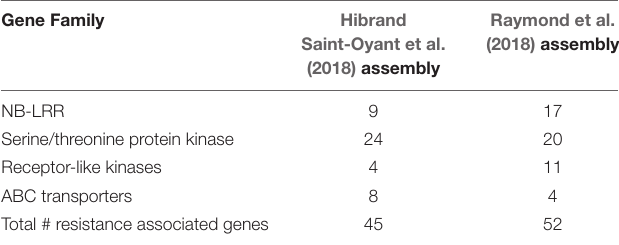
TABLE 2 | Summary of the resistance gene families identified in the Rdr4 region for the Hibrand Saint-Oyant et al. (2018) and Raymond et al. (2018) R. chinensis genome